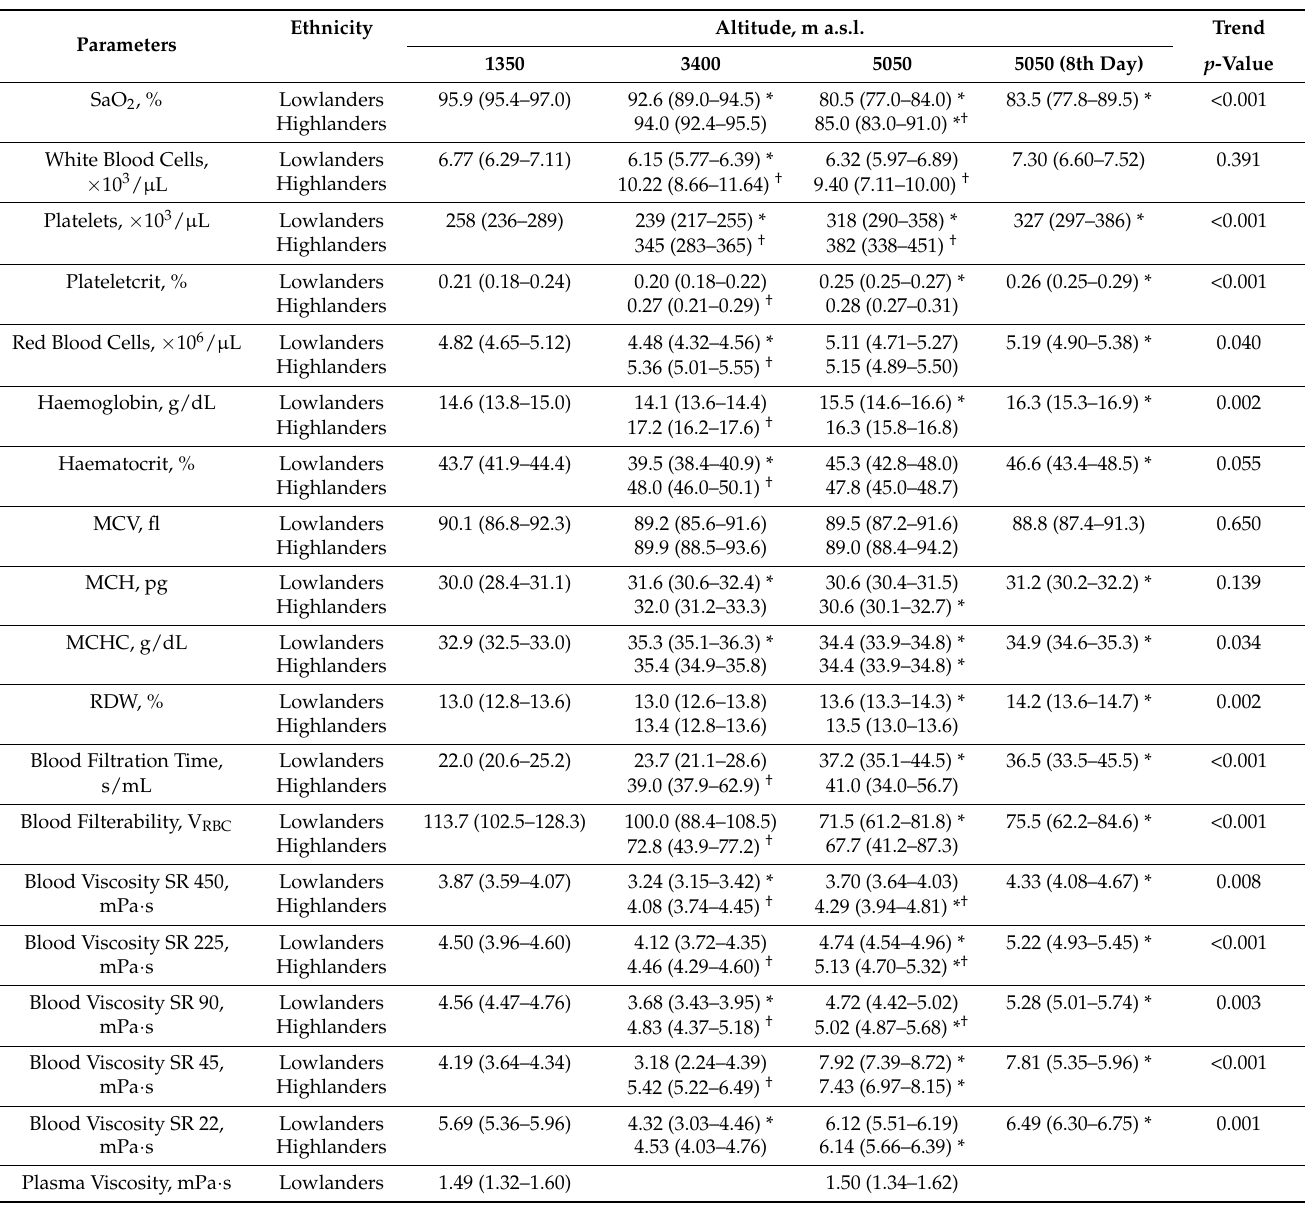
Table 2. Haematological and haemorheological changes with altitude in European lowlanders and Nepalese